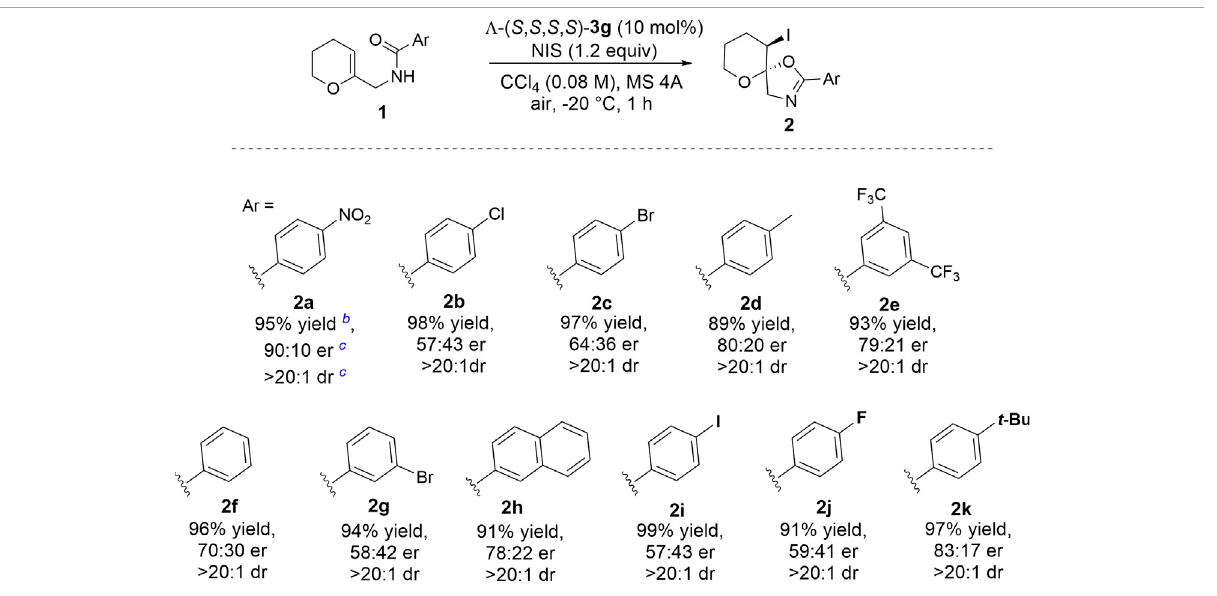
TABLE 3 Substrate scope and limitations a